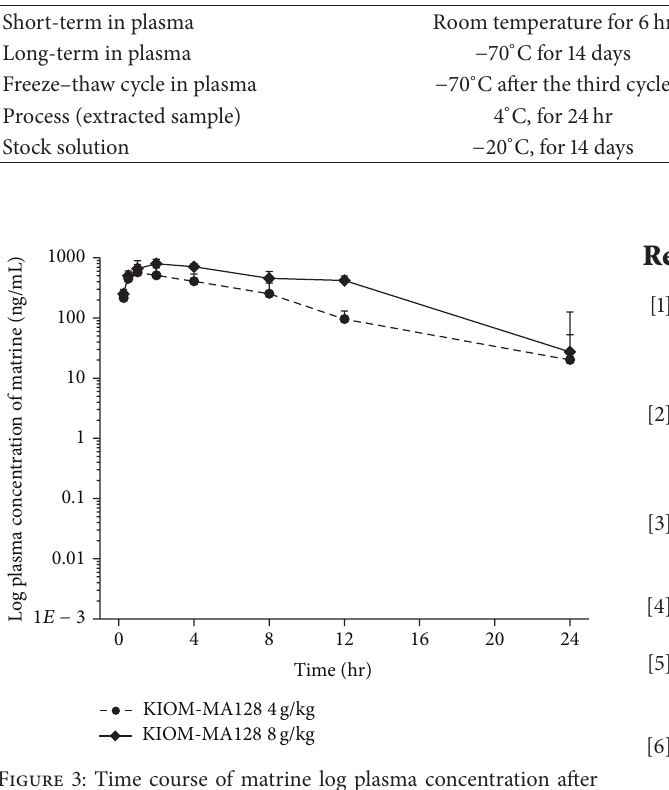
Figure 3: Time course of matrine log plasma concentration after oral administration of KIOM-MA128 4g/kg ( 𝑛 = 5 ) and 8g/kg ( 𝑛 = 5 ) in